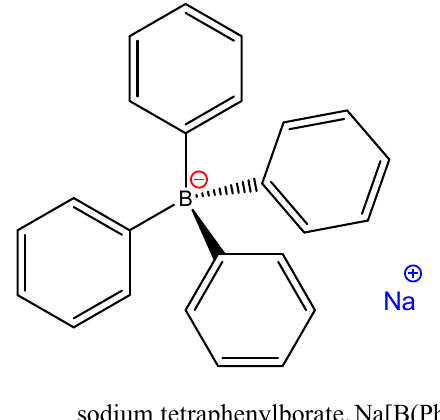
Figure 1. The secondary structure of BSA (grey cartoon) with marked Trp residues (magenta VDW representation). The first and second potential binding sites of SDS are shown with red and green rings, respectively.